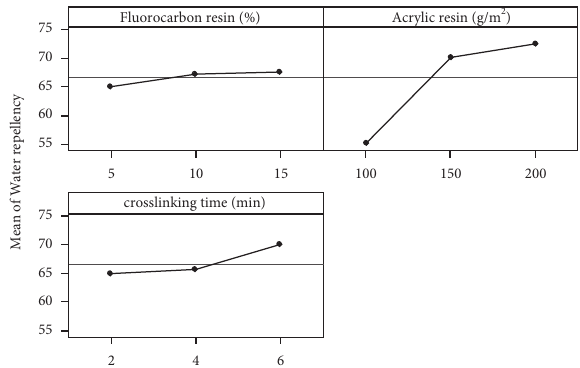
Figure 10: Main effects plot (data means) for water repellency of the coated samples.